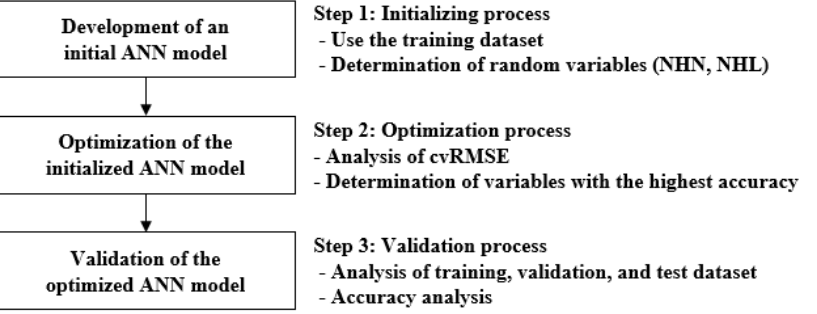
Figure 3. Brief steps for the ANN (artificial neural network) model development.